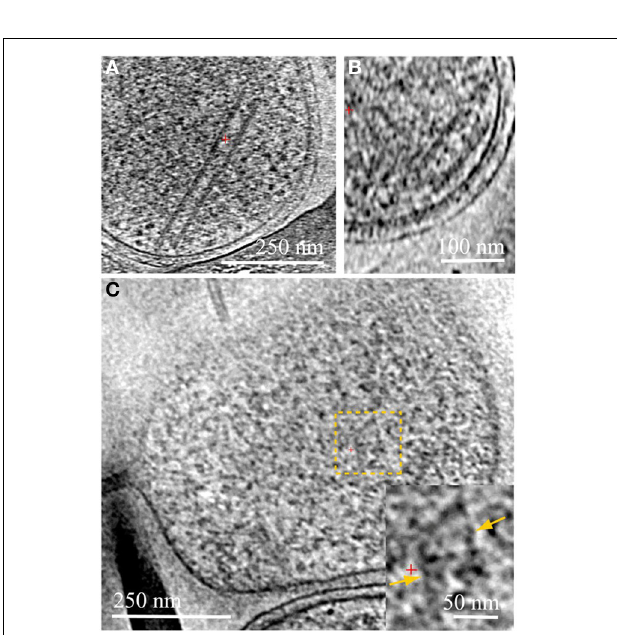
FIGURE 2 | Cytoplasmic structures in ARMAN and in Thermoplasmatales . Computational slices through 3D cryo-ET reconstructions of two ARMAN cells (A,B) and a Thermoplasma lineage cell (C) . The tubular structure in (A) is one of the longest observed, ∼ 400nm. In (B) the short tube is adjacent to the cell wall but we do not resolve any mechanistic association between tube and cell wall. These tubular structures are filled with a density typical of the cytoplasmic space including high-contrast elements. Thermoplasmatales lineage archaea can also have cytoplasmic structures in the same range of widths, such as in the cytoplasmic region within the dashed yellow box; a magnified view is shown in the inset, with the parallel boundaries indicated by yellow arrows. See also Figures S2–S6 and Movies 1 – 4 .